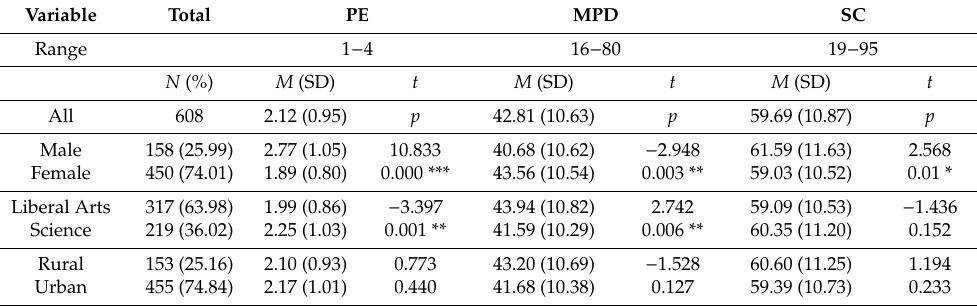
Table 1. Comparisons of physical activity (PE), mobile phone dependence (MPD), and self-control (SC) in groups based on demographic indicators in university